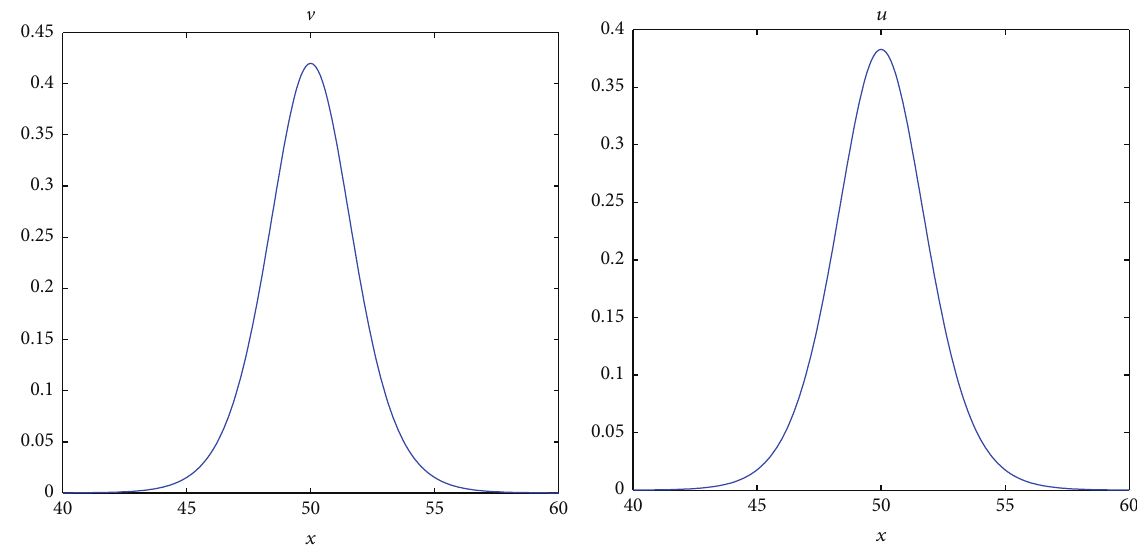
Figure 8: Solitary wave solution of system (75) for 𝛼 = 𝛽 = 0.5 , 𝜎 = 0 , and wave speed 𝑐 = 1.1 , obtained after 5 Newton’s iterations.